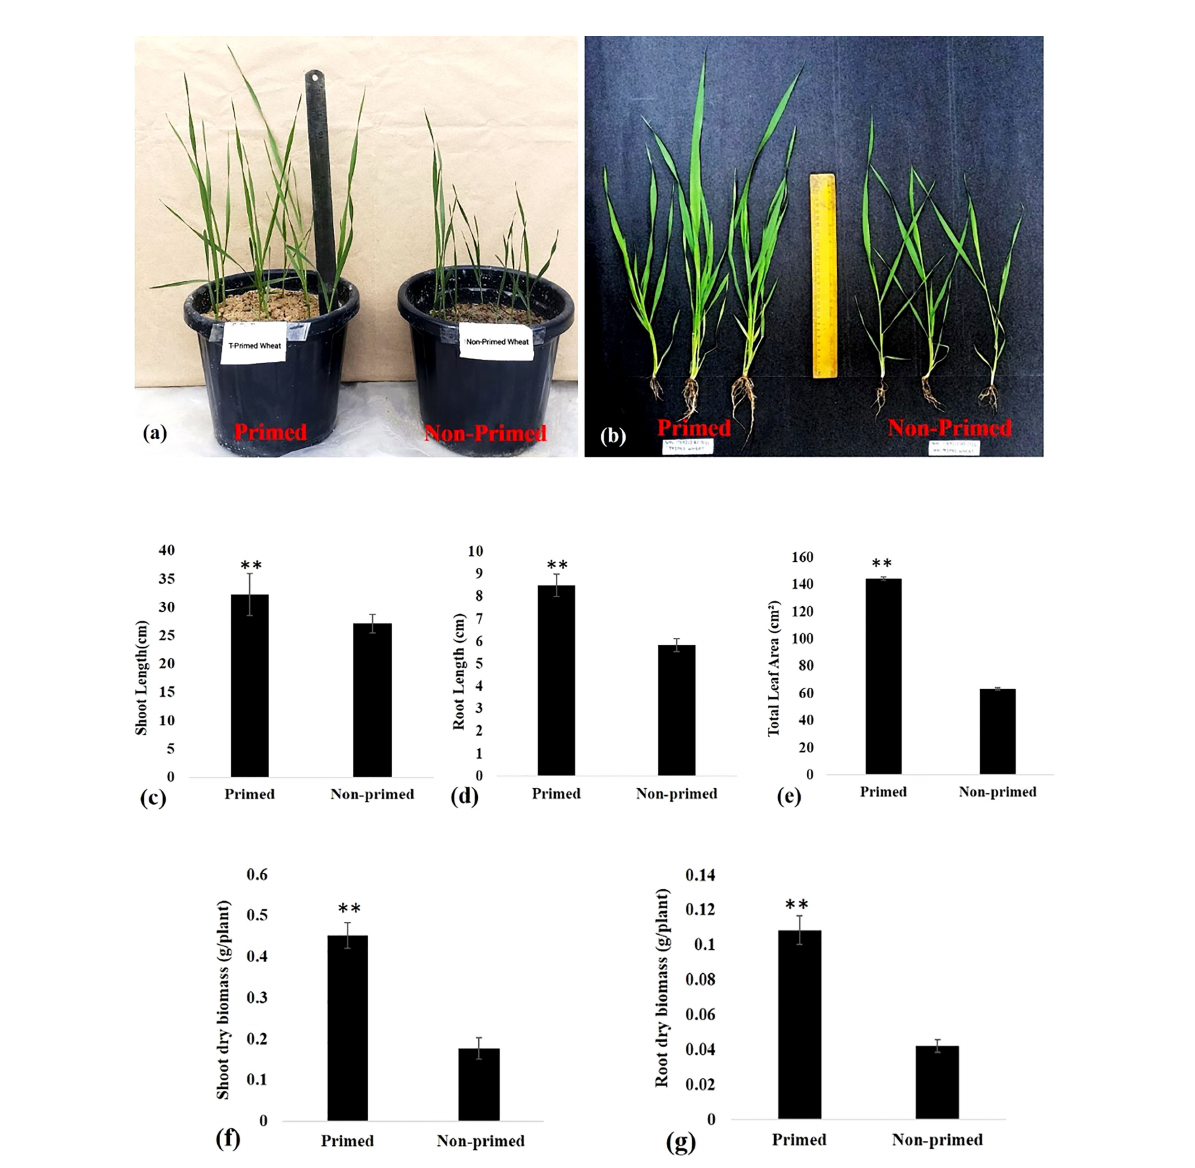
FIGURE 2 Growth of Trichoderma primed and non-primed wheat plants in G0 generation after 30 days of sowing (A) Plant height of Trichoderma primed and non-primed wheat plant. (B – D) Shoot length and root length of Trichoderma primed and non-primed wheat plant. (E) Total leaf area, (F) Shoot dry biomass, (G) Root dry biomass. Data in c, d, e, fand g are represented as mean ± SD, and P values (**P< 0.01) are indicated by student's t-test. Results are representatives of three independent biological replicates.